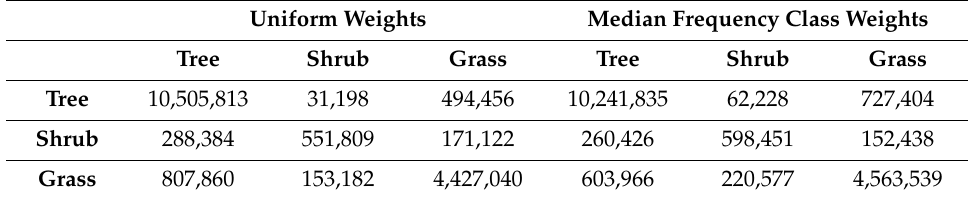
Table 18. Confusion matrices for uniform and median frequency class weights (Oregon—3 classes).